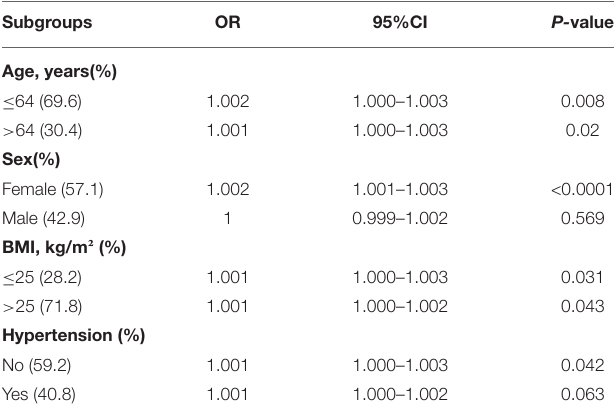
TABLE 2 | Subgroup analysis of the association between MMP9 level and CAC progression.